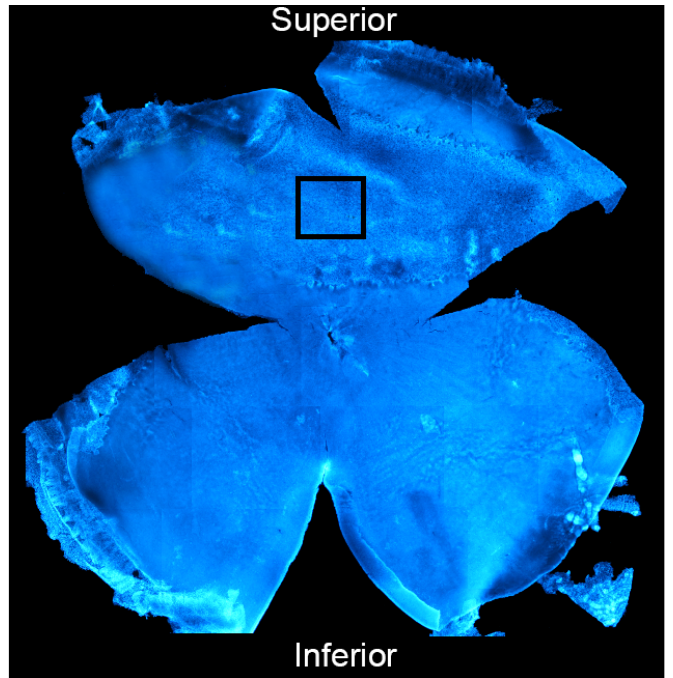
Figure 2. Representative image of a whole mounted retina. The image was obtained by reconstruc- tion from multiple images acquired with a fluorescence microscope; the retina was stained with bisbenzimide nuclear dye (blue). The black frame highlights the central superior retina, that is, the area selected for the analysis of the retinal